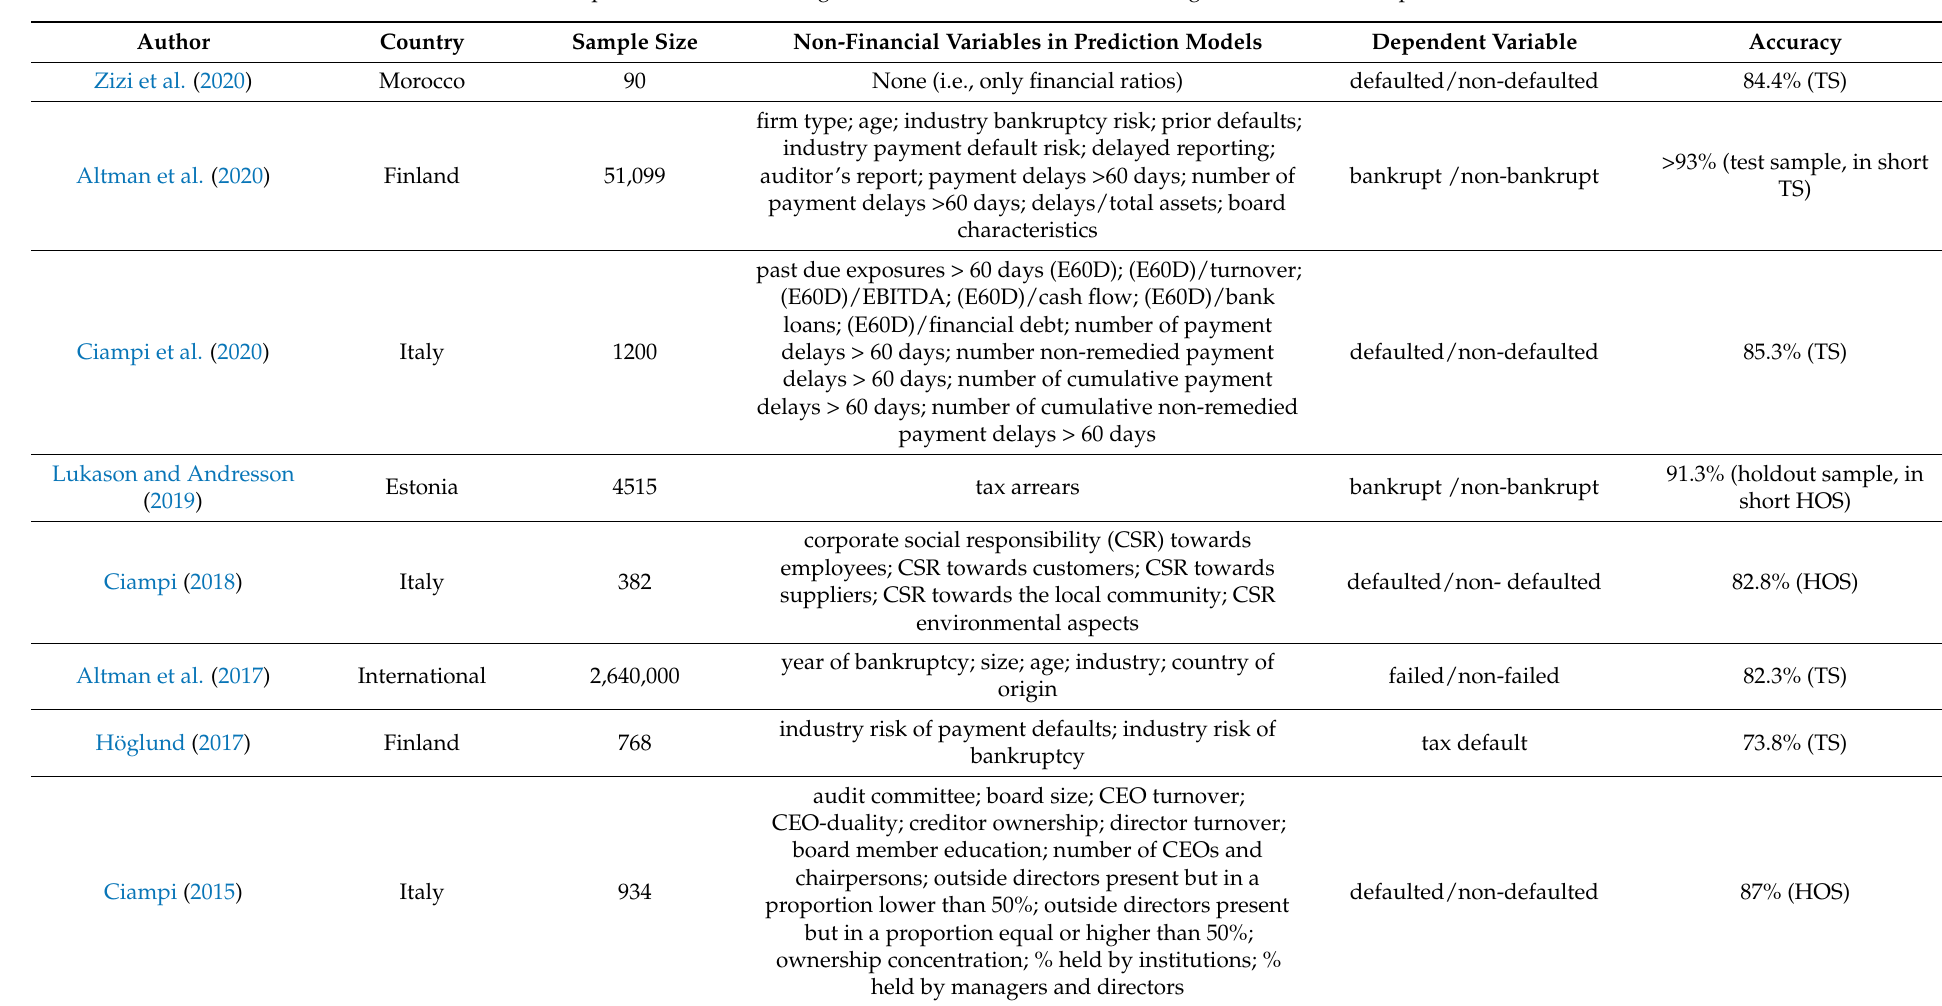
Table A1. Failure prediction articles using non-financial variables and/or using loan default as a dependent